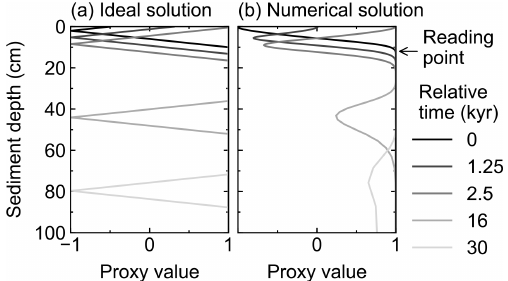
Figure 4. Comparison of ideal (a) and numerical (b) solutions for burial advection of the proxy signal. To minimize the effect of nu- merical diffusion in numerical solution, signal values are read at just below the mixed layer as denoted by an arrow.